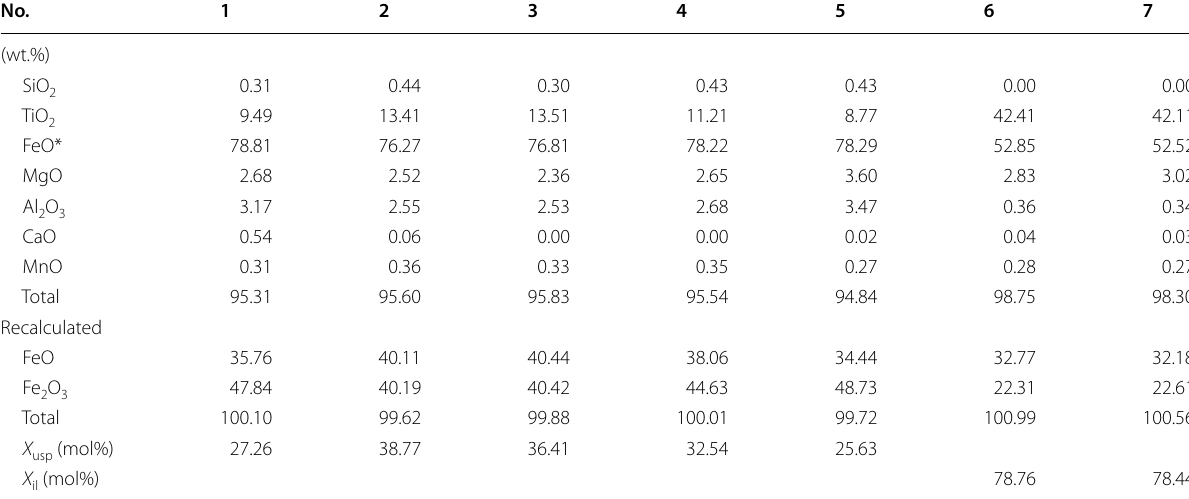
Nos. 1 and 2 are TM (Type I) of 2p. Nos. 3 and 4 are TM of 21pu. No. 5 is the TM (Type II) of symplectite. No. 6 is TH of 2p. No. 7 is TH of 21pu. FeO*: total iron as FeO. Recalculations for ferric iron contents are based on Carmichael (1967). X usp and X il are ulvöspinel content of TM and ilmenite content of TH, respectively